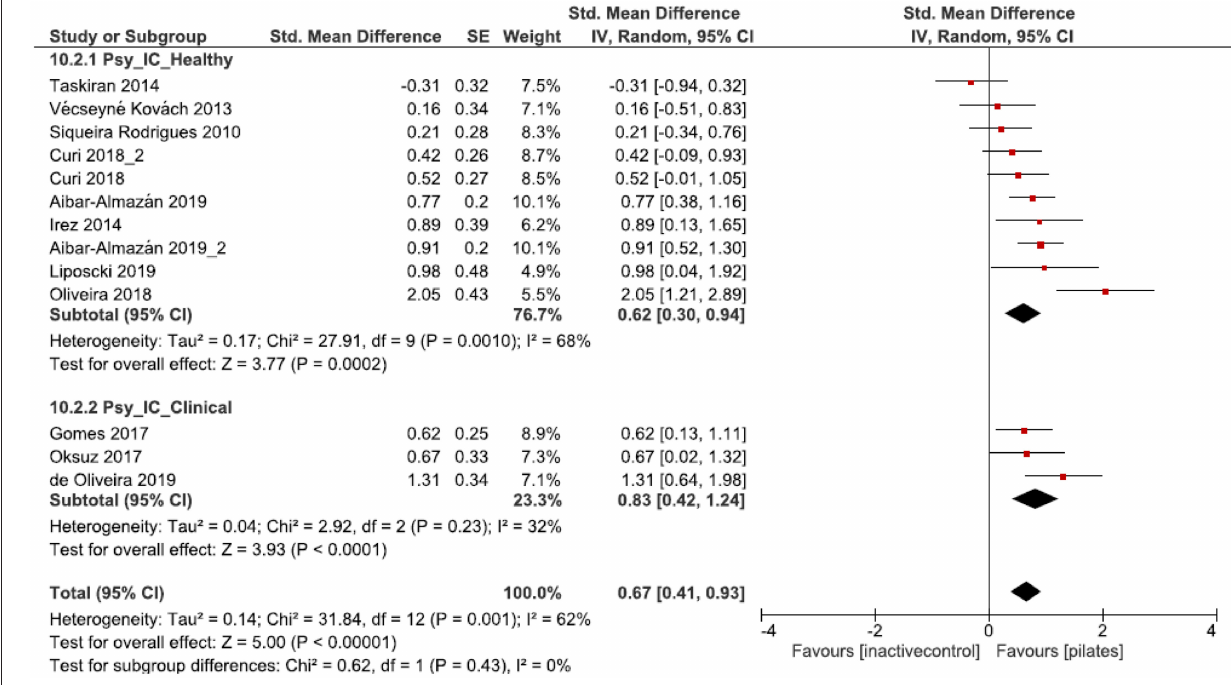
FIGURE 5 | Forest plot of standardized mean effects of Pilates intervention on psychological health parameters compared to inactive control (IC) groups. Data are presented for healthy older adults and older adults with clinical conditions. SE, standard error; IV, inverse variance model; CI, confidence interval; Std.,